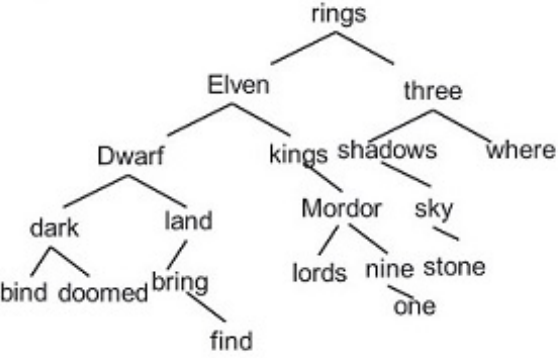
Figure 4. An example of the Binary Search Algorithm.